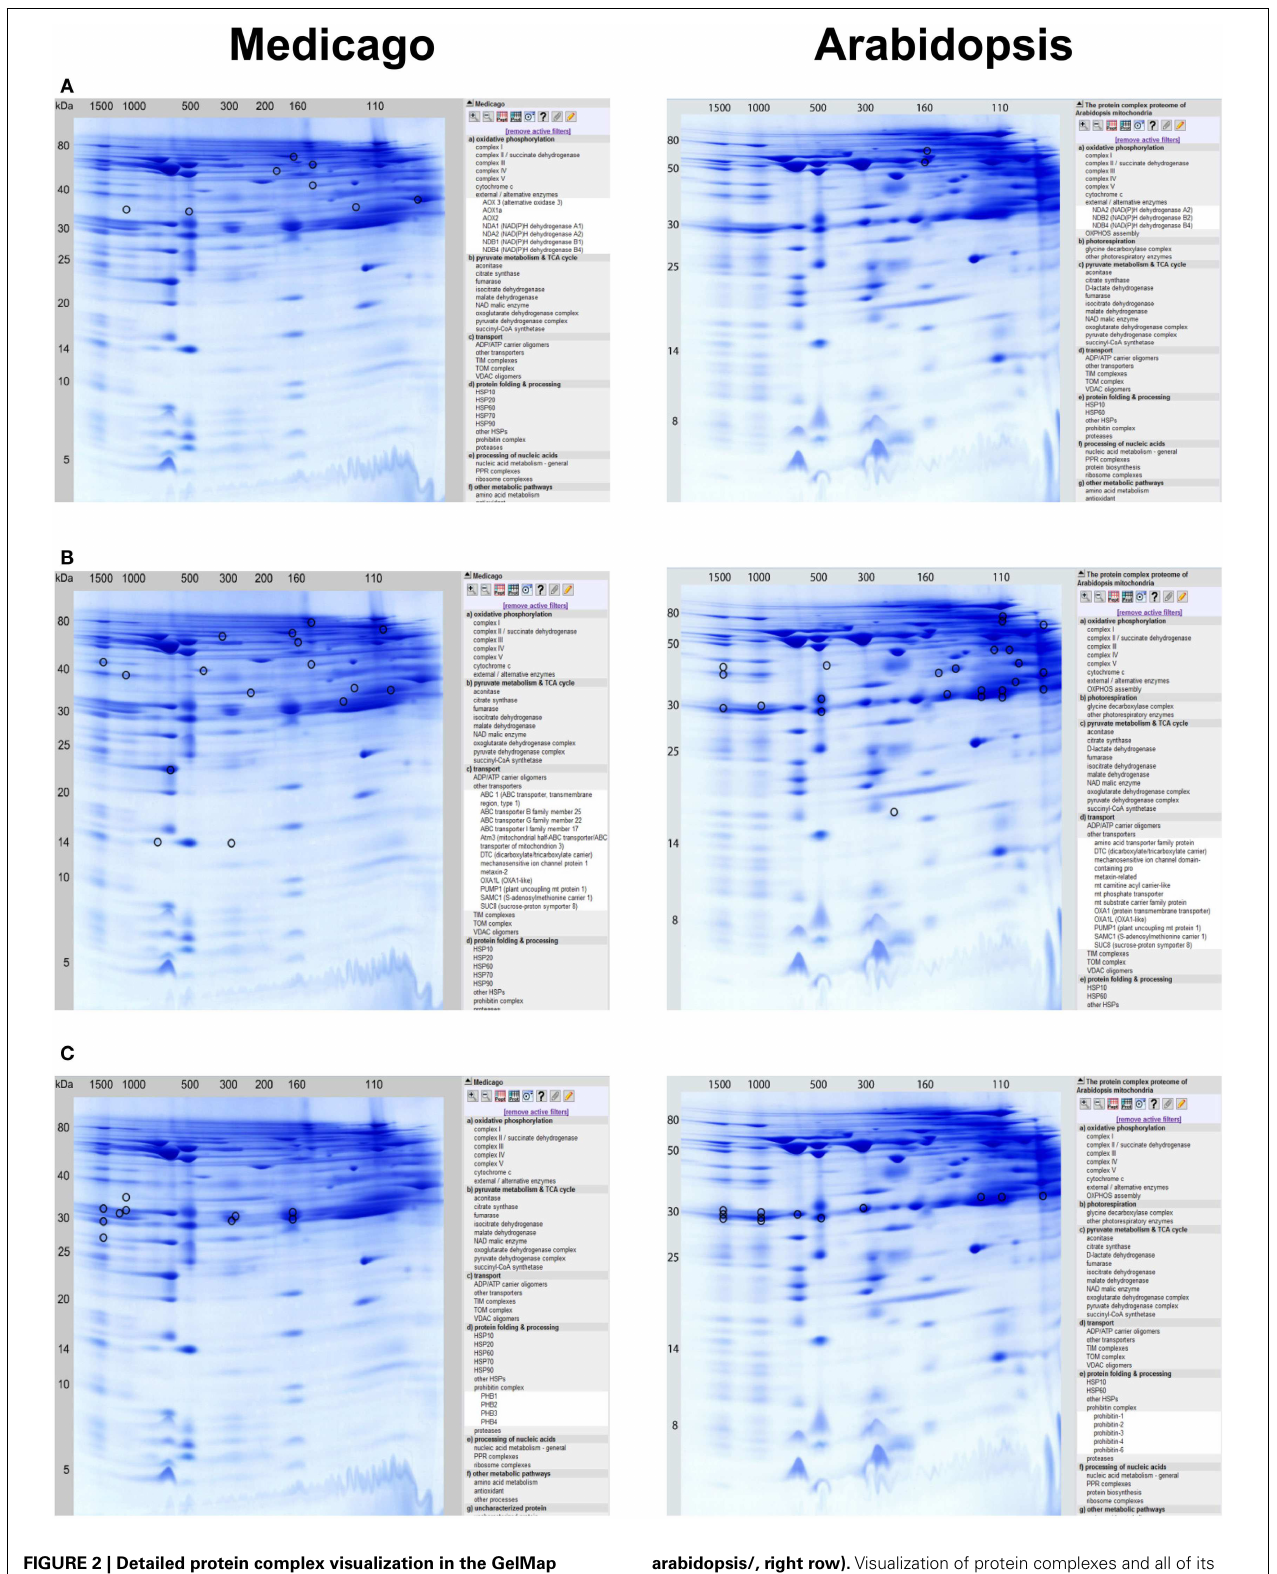
FIGURE 2 | Detailed protein complex visualization in the GelMap reference maps of the Medicago mitochondrial complexome (http://www.gelmap.de/medicago/, left row) as compared to the Arabidopsis mitochondrial complexome (http://www.gelmap.de/